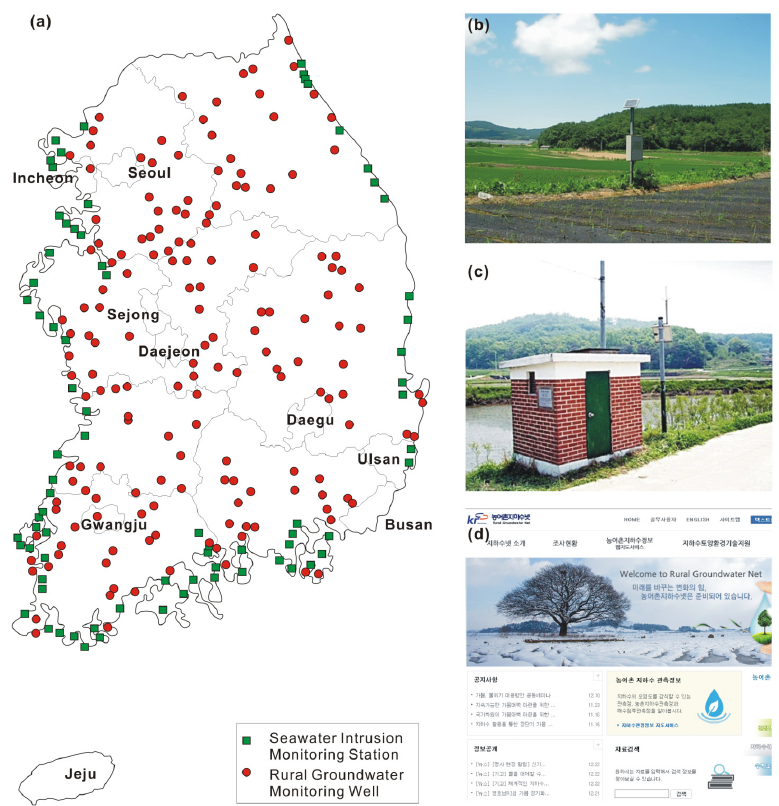
Figure 5. ( a ) Locations of the Seawater Intrusion Monitoring Network (SIMN) wells and the Rural Groundwater Monitoring Network (RGMN) wells; ( b ) scene of the seawater intrusion monitoring station; ( c ) scene of the rural groundwater monitoring well; and ( d ) webpage screenshot (www.groundwater.or.kr) showing the results of the two groundwater monitoring networks.